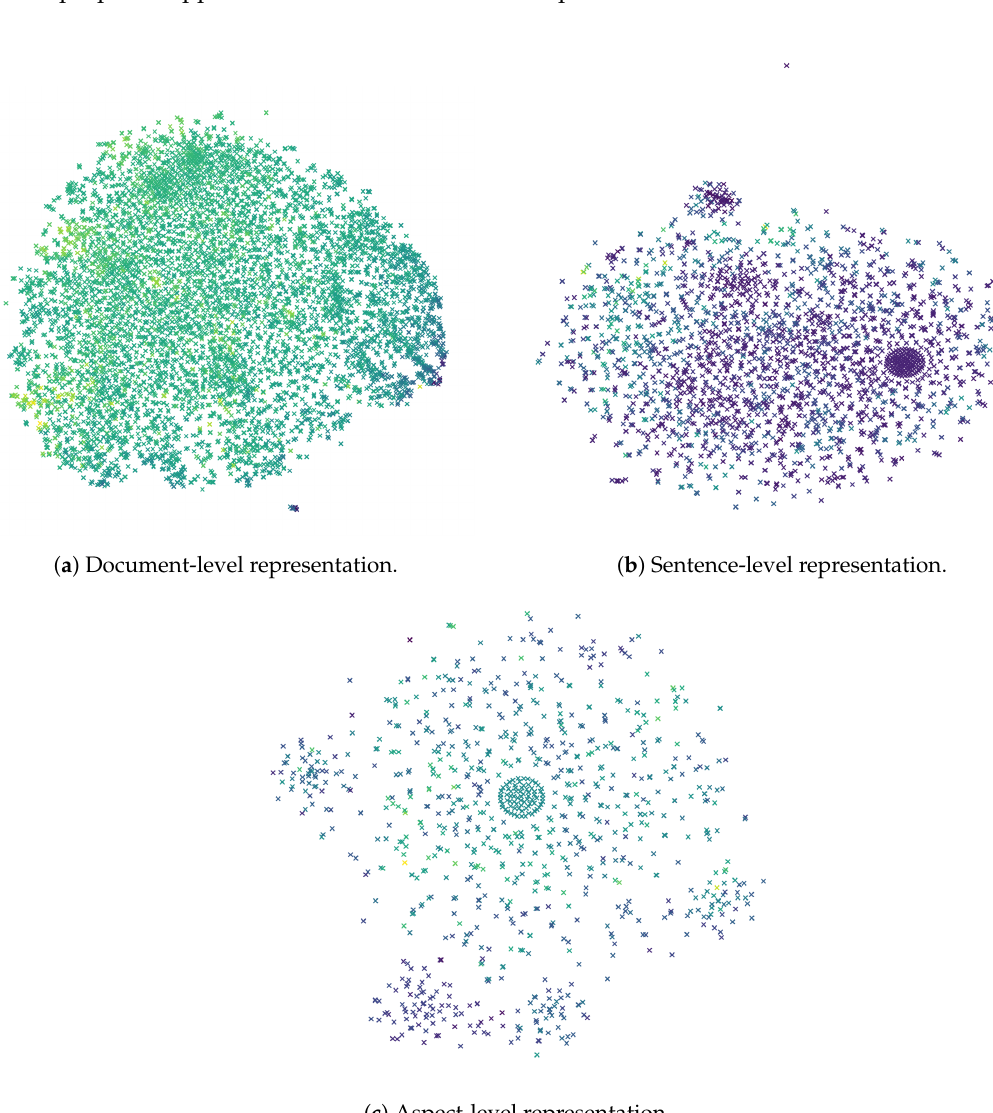
Figure 4. t-Distributed Stochastic Neighbor Embedding (t-SNE) visualizations of the document, sentence, and aspect representations learned by our proposed adversarial model on the three test datasets. The color indicates different class labels. ( a ) Document-level representation using the GAN model; ( b ) Sentence-level representation using the GAN model; ( c ) Aspect-level representation using the GAN